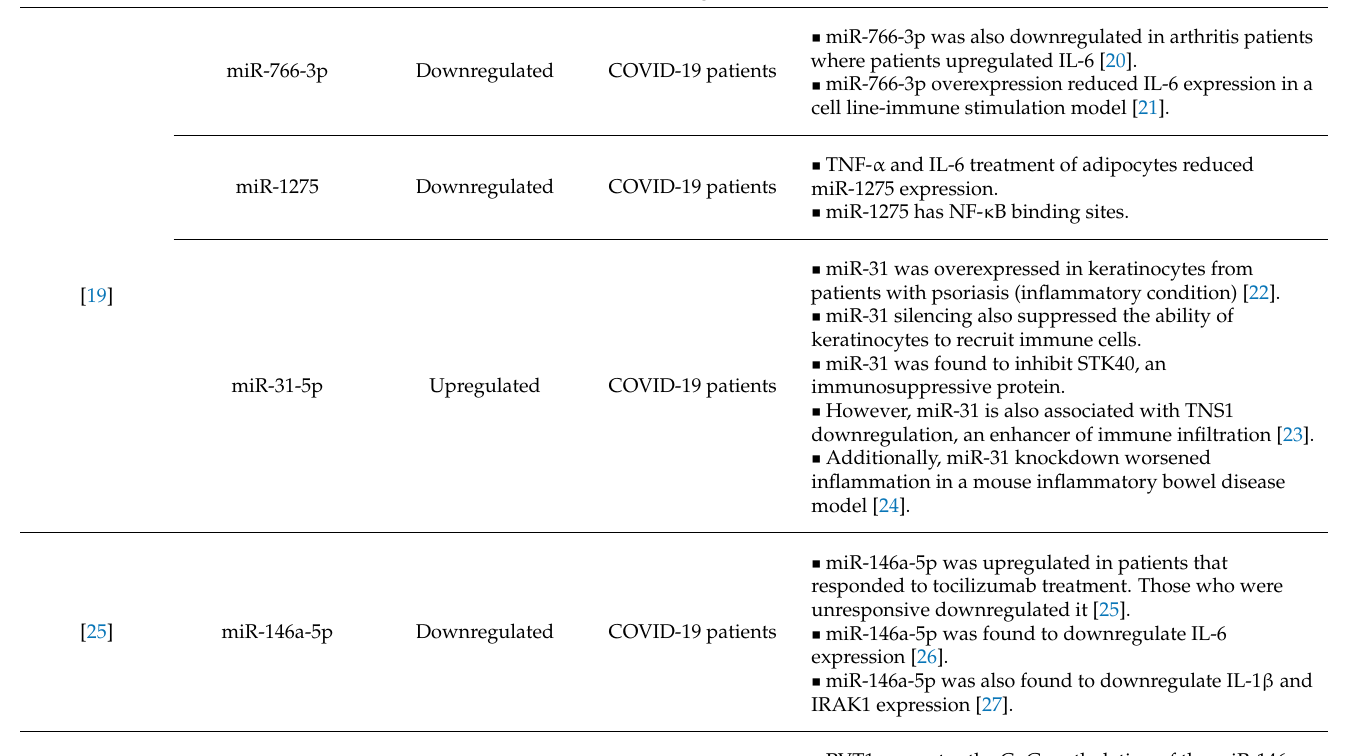
Table 1. A summary of the published COVID-19 ncRNA profiling studies with relevant literature highlighted.